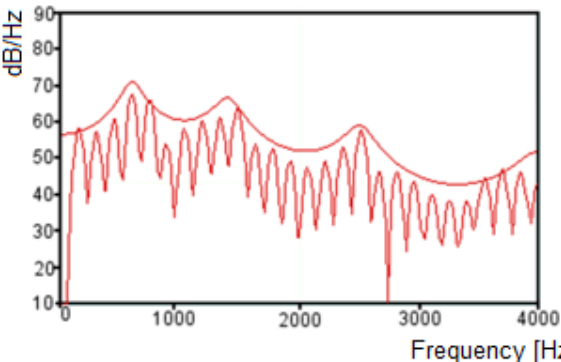
Figure 1. Fourier spectrum and linear predictive coding (LPC) envelope for a given audio signal.